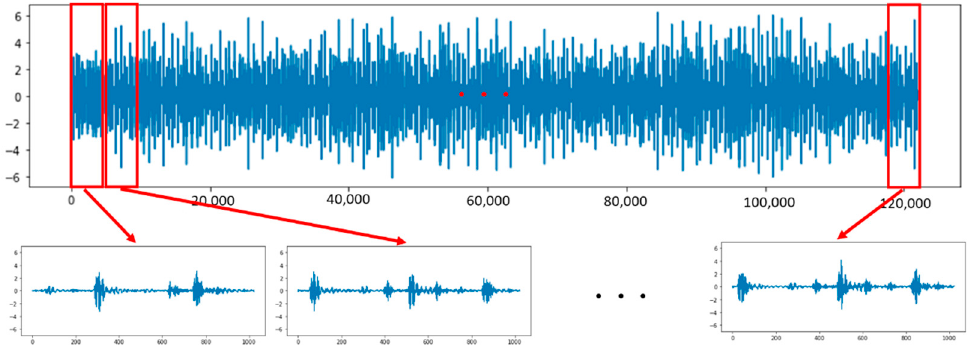
Figure 8. Processed data segment.